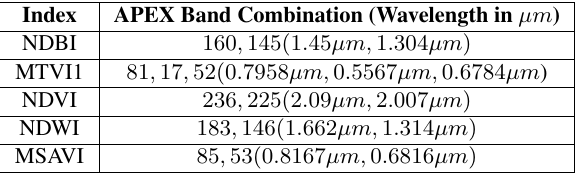
Table 1: Spectral indices retained for outliers detection detection.